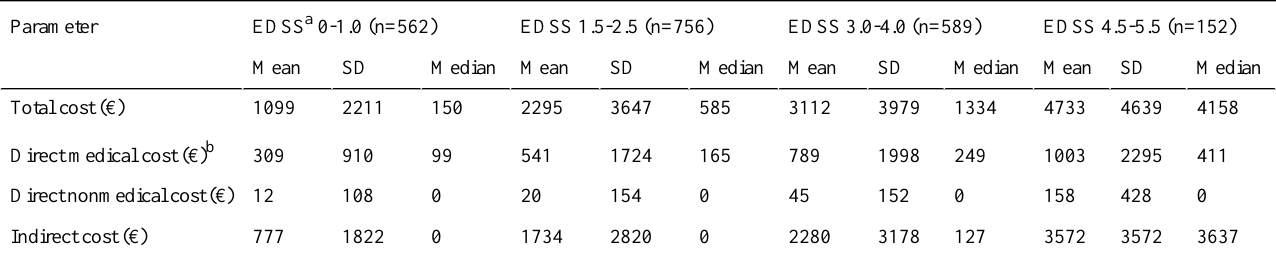
Table 6. Known-group analysis: health resource utilization costs of patients with multiple sclerosis per quarter by disability